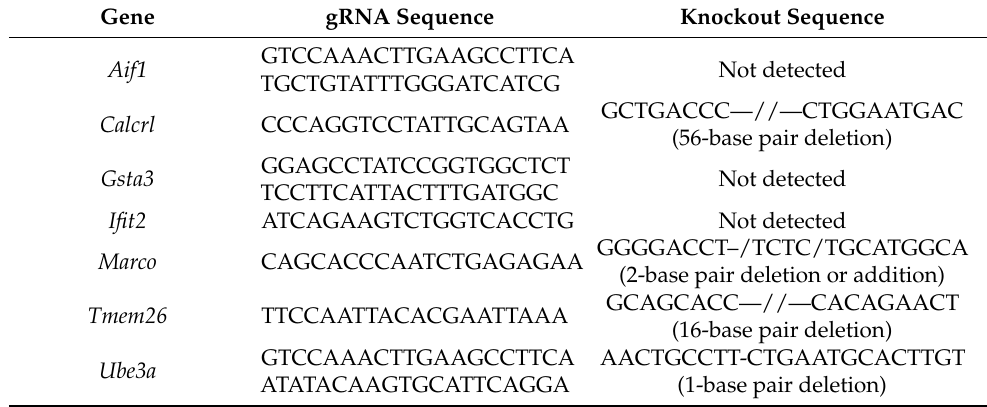
Table 3. Target genes knocked out in RAW 264.7 cells using the CRISPR-Cas9 tool.